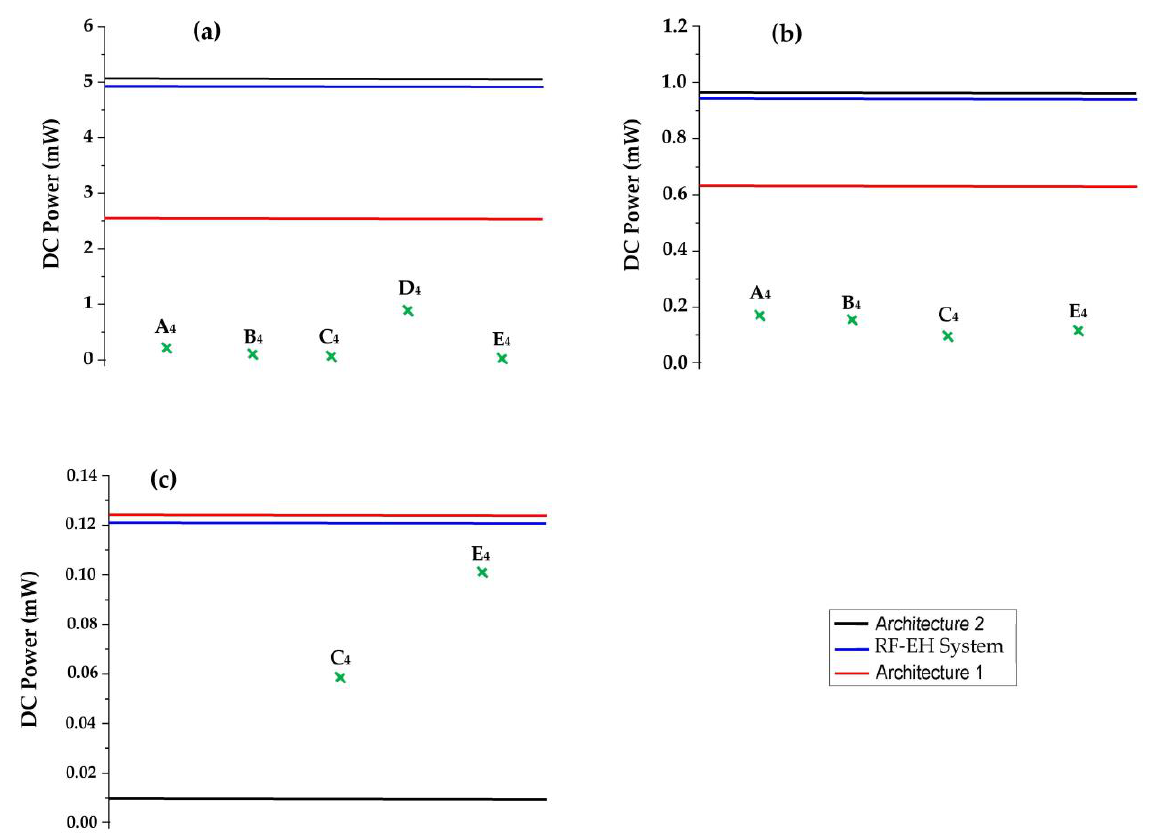
Figure 34. Feeding ability of the RF-EH system and architectures at ( a ): 22 m, ( b ): 40 m, and ( c ): 110 m from relay antenna compared to minimum required power supply of the biomedical sensors. The DC powers A 4 , B 4 , C 4 , D 4 and E 4 correspond to the power supply of sensors presented in the references [40 – 44], respectively .